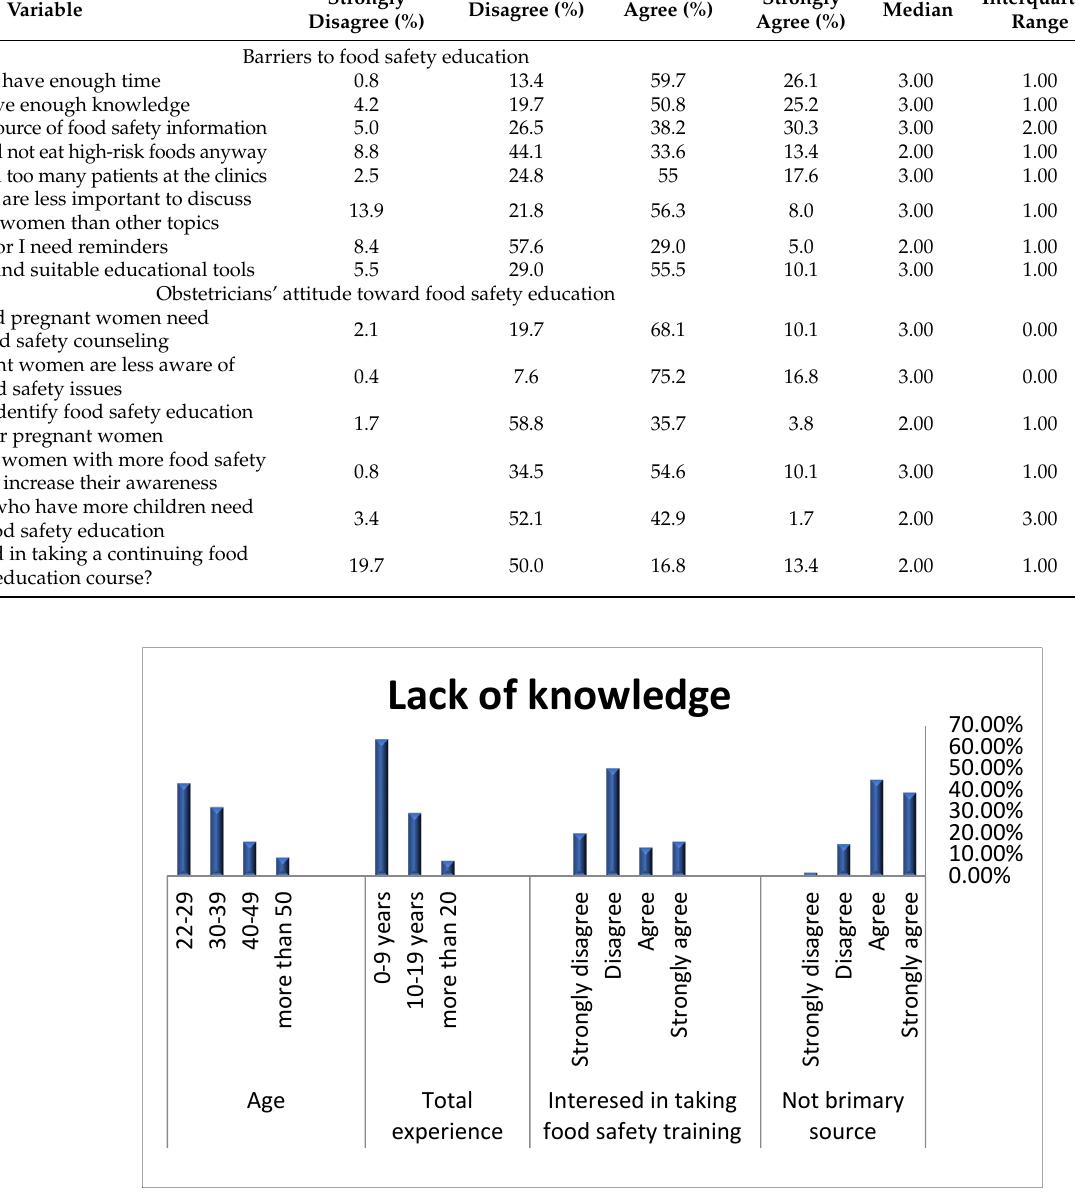
Figure 1. Correlation between lack of knowledge and selected variables. “Agree” and “strongly agree” were considered to be a Yes = 2 (having a lack of knowledge), while “strongly disagree” and “disagree” were considered to be a No = 1.